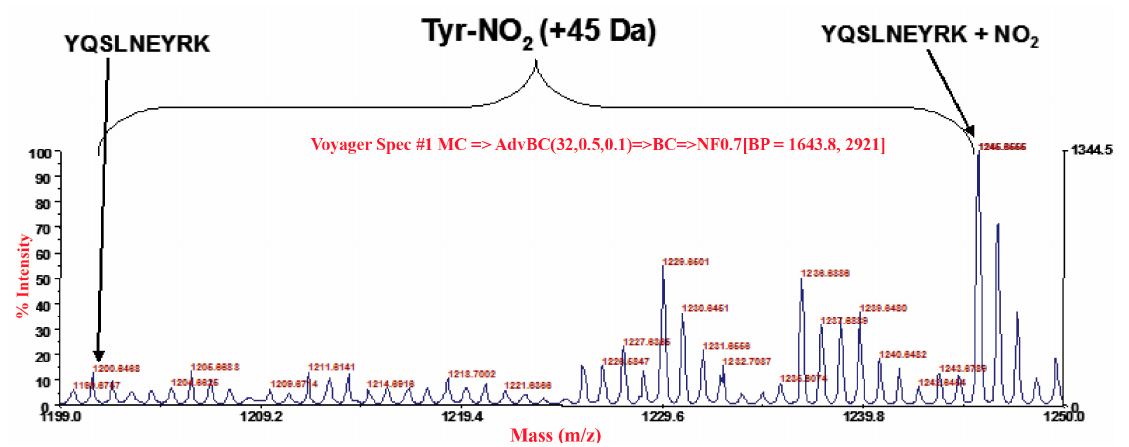
Figure 6. Identification of nitrated tyrosine of COX-2 after the administration of carrageenan.